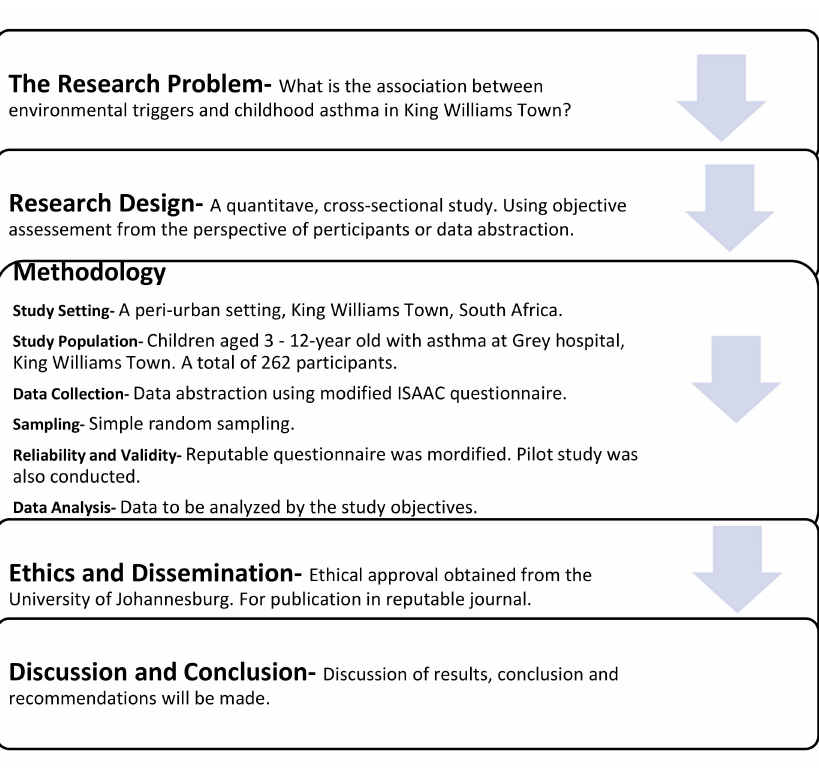
Figure 1. A flow diagram of the